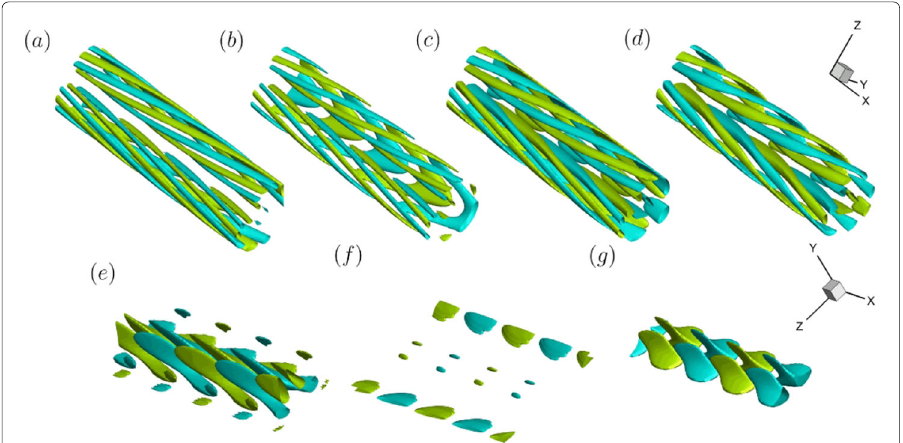
Fig. 6 The spatial structure (depicted by temperature isosurfaces with value of ± 50% of the maximum) of unstable modes shown in the order of decreasing phase velocities at x = 319 mm: ( a ) mode V7, ( b ) mode V2, ( c ) mode V6, ( d ) mode V5, ( e ) mode V1, ( f ) mode V3, ( g ) mode